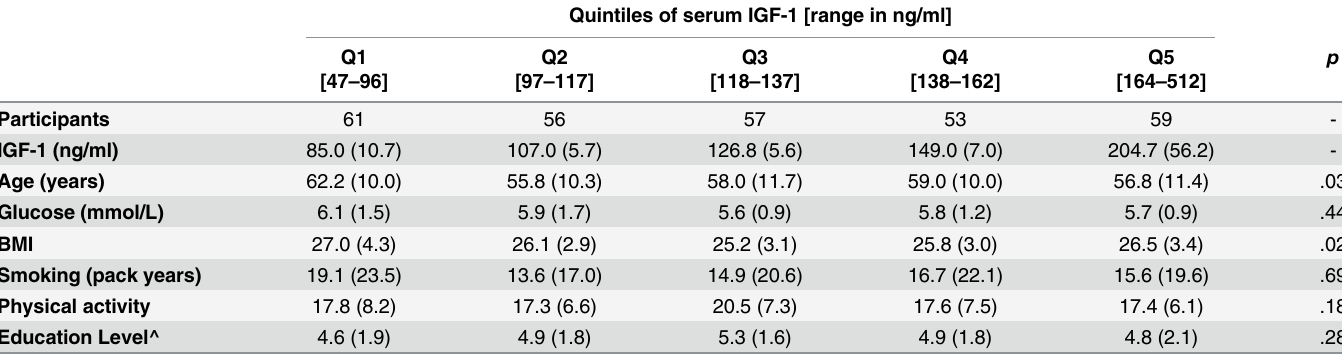
Table 1. Baseline characteristics and cognitive performance of participants assessed at follow-up (n = 286) according to quintiles of IGF-1.